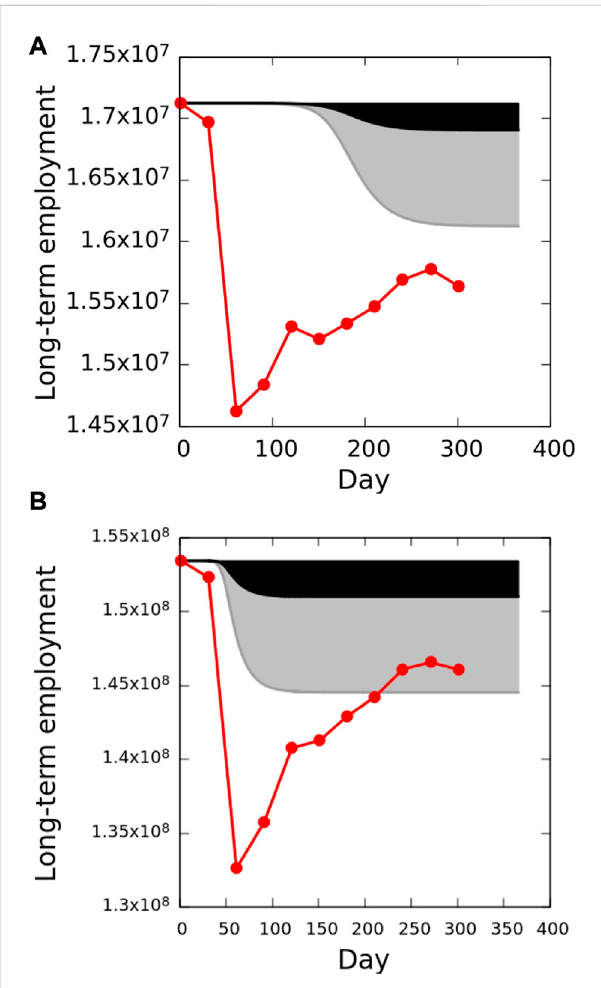
FIGURE 8 Comparisons of unemployment forecast by the business-as- usual model and actual unemployment of March to December, 2020. (A) — California state; (B) — United States. The key to the plots are explained in Figure